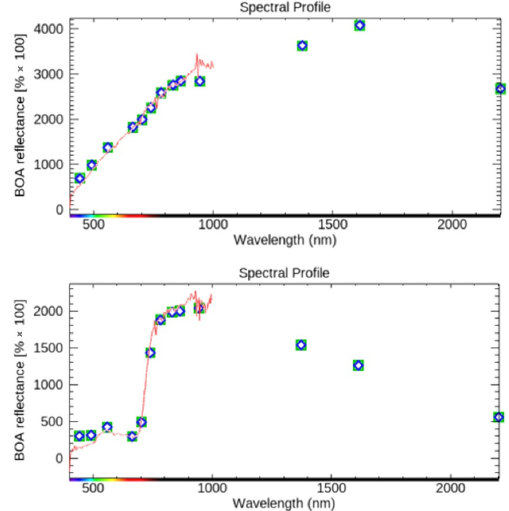
Figure 15. BOA reflectance (%) of a soil (a) and a vegetation (b) pixel for hyperspectral DESIS processing (line, red), multispectral DESIS-S2-VNIR processing (diamond, blue) and MS DESIS-S2 processing (square, green). The spectra correspond to a mean over 2 × 2 pixels (upper) and 3 × 3 pixels (lower) to integrate the same geographical area.